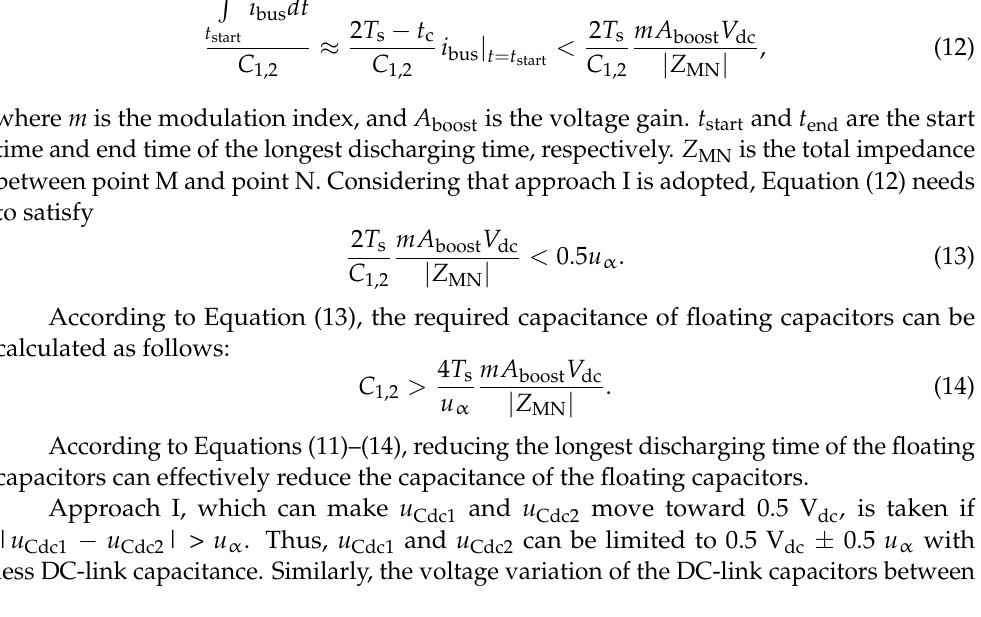
According to Equations (11)–(14), reducing the longest discharging time of the floating capacitors can effectively reduce the capacitance of the floating